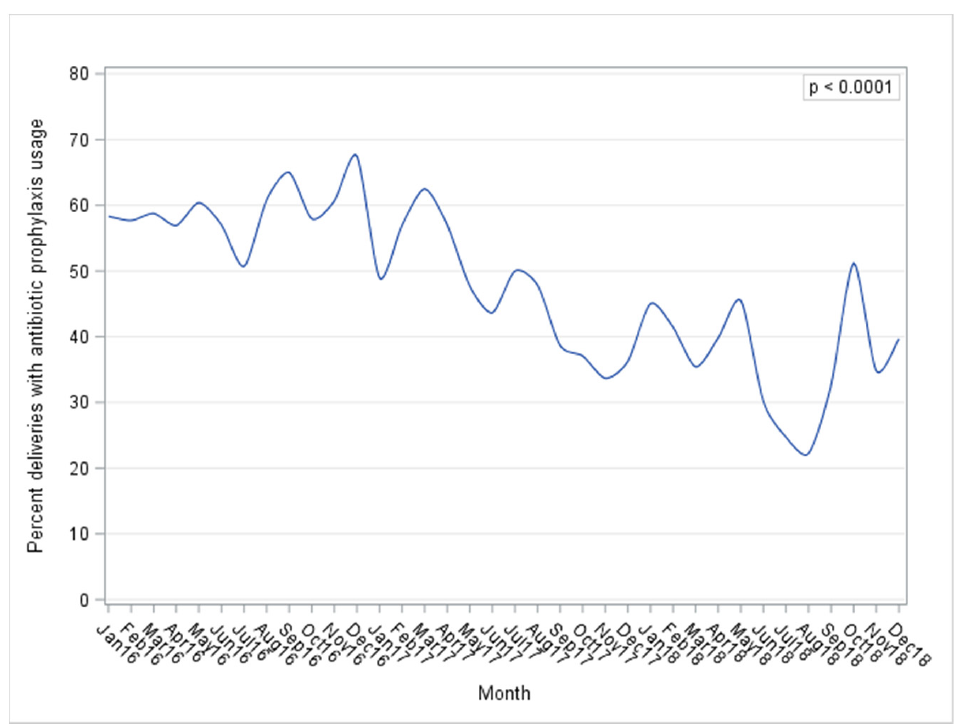
Figure 1. Percentage of deliveries with prophylactic antibiotic use during 2016–2018.